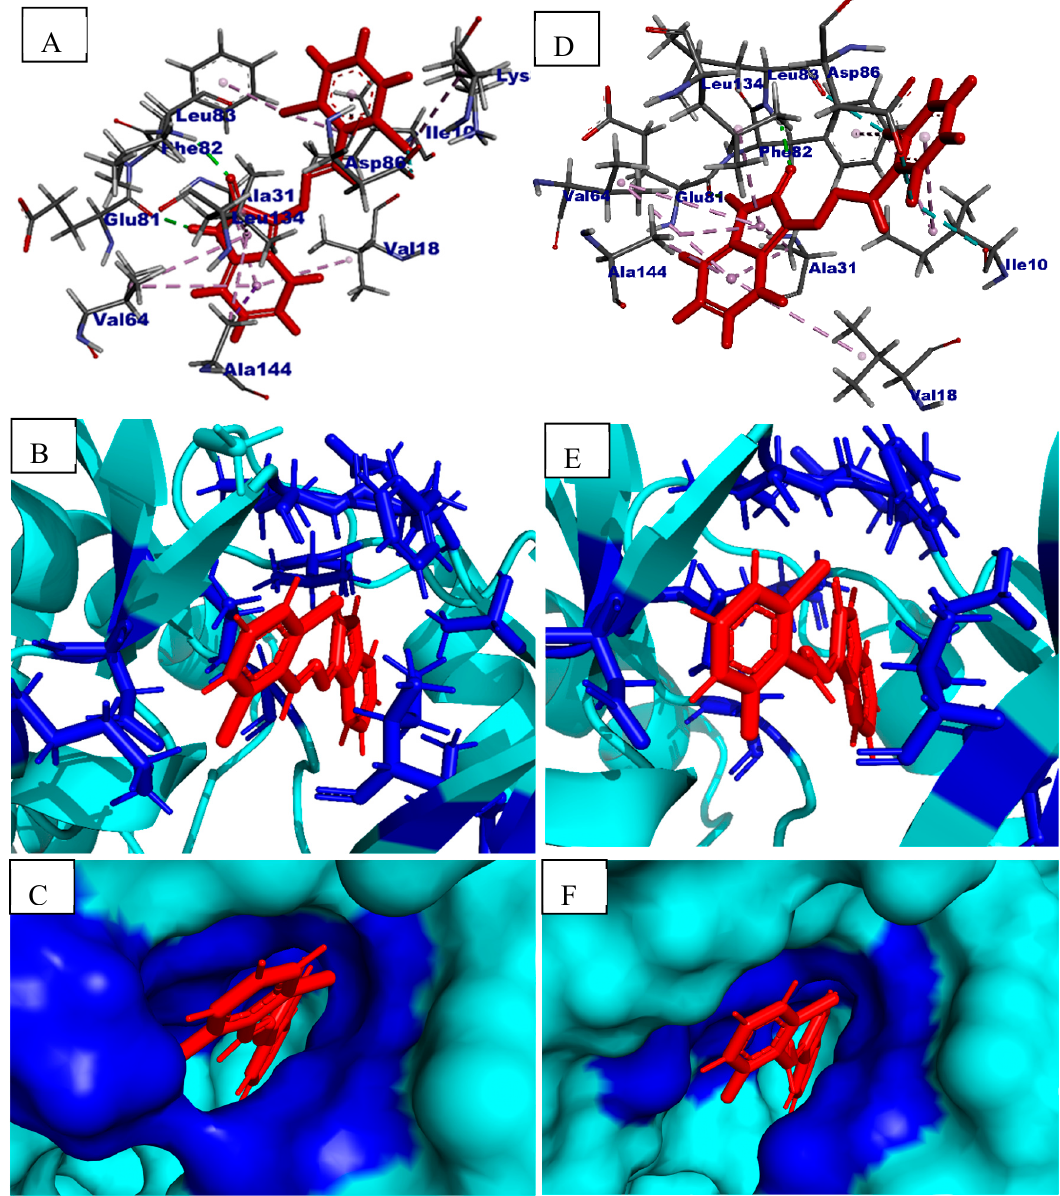
Figure 4. ( A ) 2D docking pose of 4j within the active site of CDK2; ( B ) 3D docking pose of 4j within the active site of CDK2; ( C ) binding pocket formed by interacting residues of active site of CDK2 surrounding 4j ; ( D ) 2D docking pose of 4k within the active site of CDK2; ( E ) 3D docking pose of 4k within the active site of CDK2; ( F ) binding pocket formed by interacting residues of active site of CDK2 surrounding 4k . Compounds are shown in red color, protein in cyan and interacting residues in blue color. Table 4. Docking score, interacting residues and types of interaction mediated by 4j and 4k with the ATP binding pocket of CDK2 protein kinase.